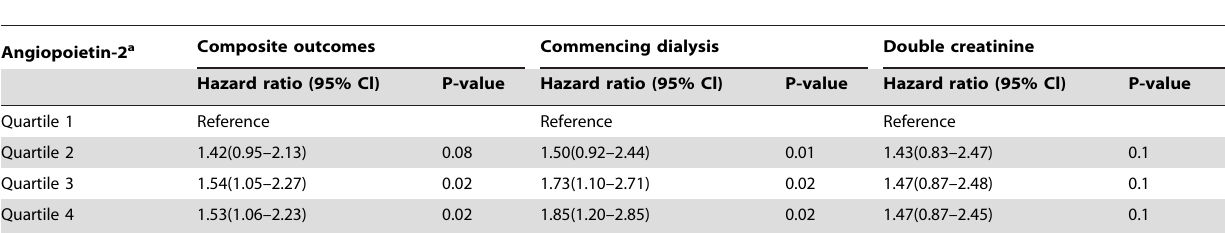
Table 3. The adjusted risks for composite outcomes, either commencing dialysis or doubling creatinine according to Angiopoietin-2